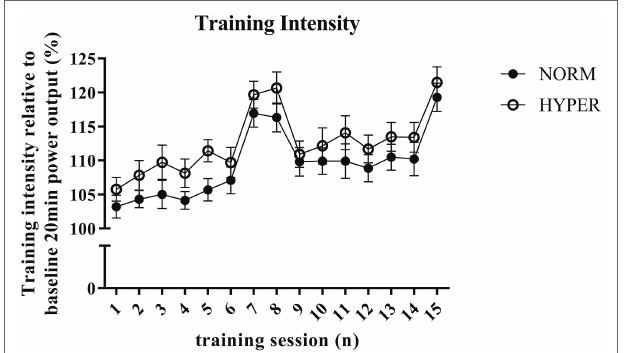
FIGURE 1 | Overview of the training intensity and progression of the normoxic (NORM) and hyperoxic (HYPER) group during the 6-week training intervention. Training intensity of each high-intensity interval session is expressed in percentage of the mean power output obtained during the baseline self-paced 20-min cycling trial. Note that the higher training intensity during training session number 7, 8, and 15 is attributed to the higher exercise intensity obtained when performing 4 × 4 min interval training session instead of the otherwise performed 3 × 8 min intervals. This figure shows (1) the numerically but not significantly higher training intensity performed by HYPER compared to NORM throughout the training intervention which was independent of the interval duration, (2) the increasingly higher training intensity performed by both groups during the intervention period which indicated that cycle performance was enhanced in both groups independent of hyperoxia.